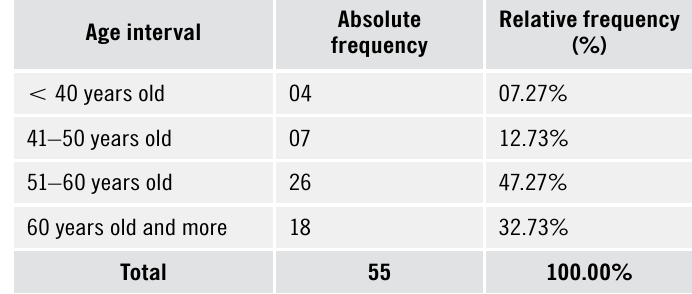
Table 5. CEO by different age groups